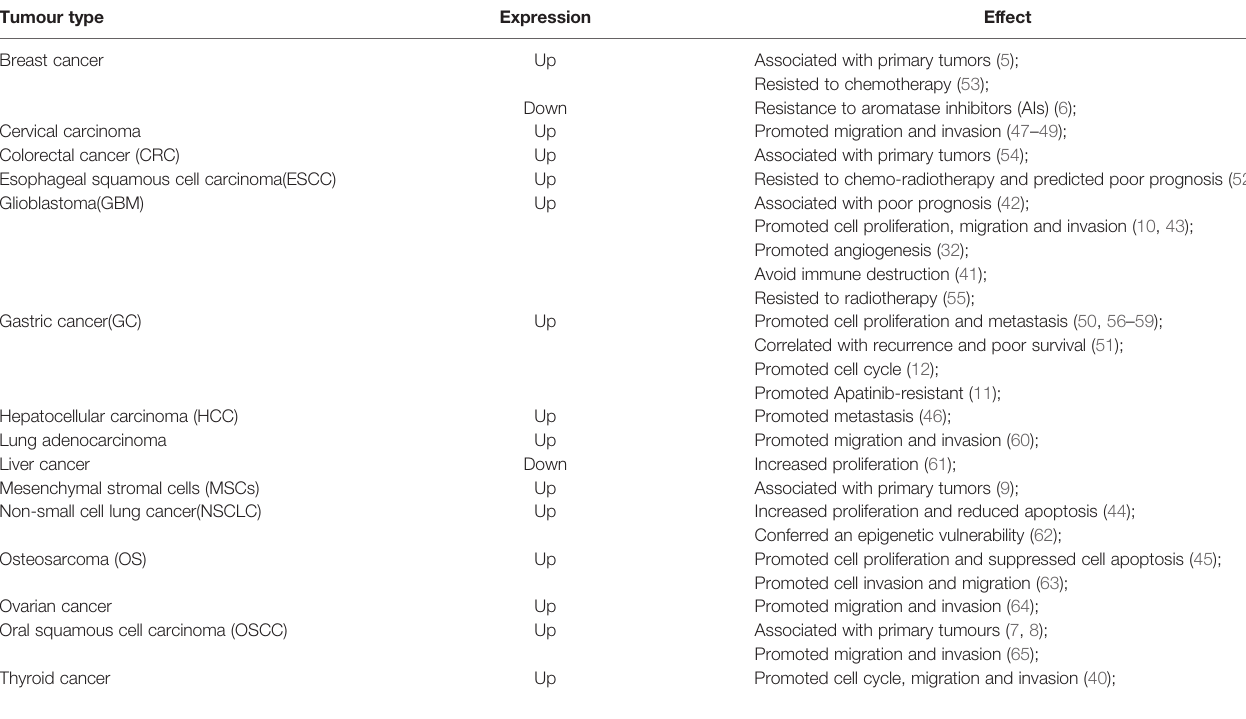
TABLE 1 | HOXC10 expression and function in various